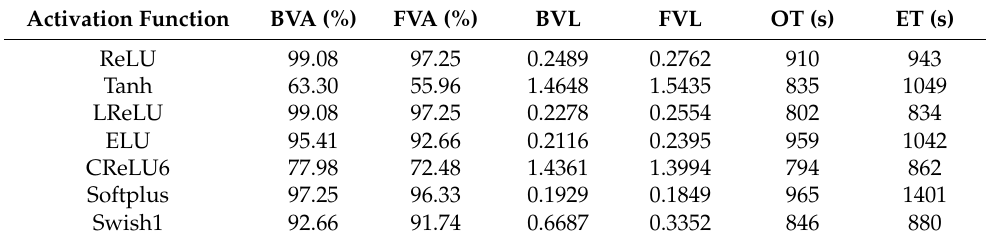
Figure 8. Trends of validation loss for transfer learning on ResNet50 with seven different activation functions. Table 4. Training results of seven ResNet50 network architectures improved by single activation